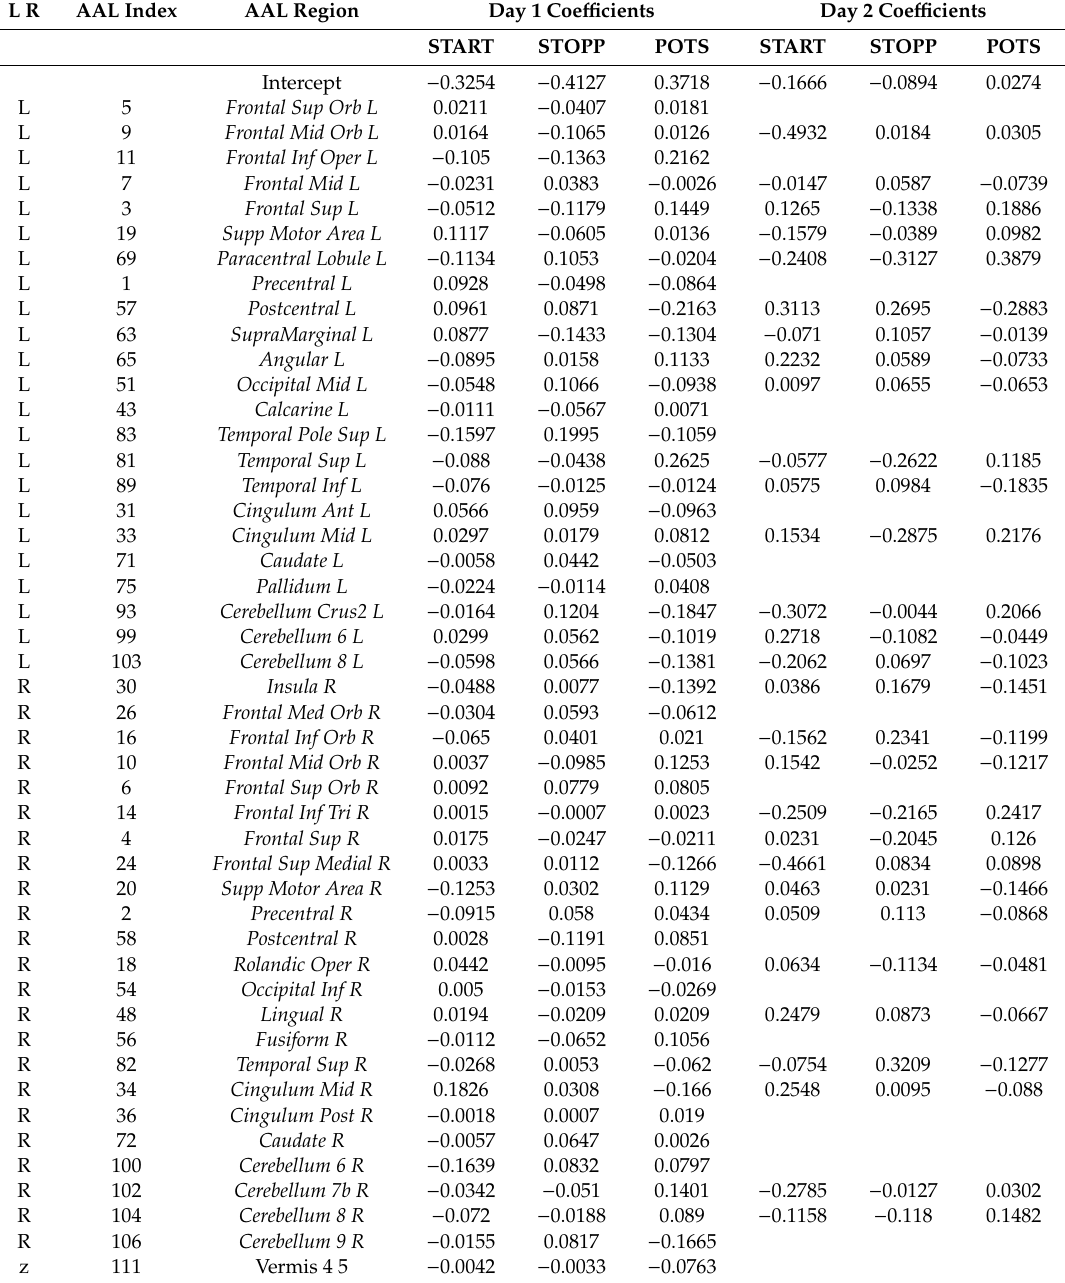
Table 7. AAL regions in logistic regression models that distinguished GWI START, STOPP, and POTS subsets on Day 1 and Day 2. Recursive feature elimination identified regions that significantly separated the GWI subsets on Day 1 and Day 2. The models identified the combinations of regions with di ff erent numbers of significant voxels ( t > 3.17, p < 0.001 for the 2 > 0-back condition) per ROI. Day 2 regions were a subset of Day